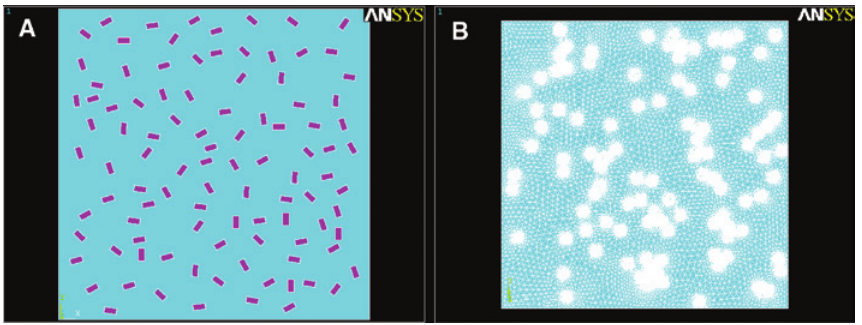
Figure 1: Finite element model of the 10 vol% epoxy composites with (A) rectangular particles and (B) round